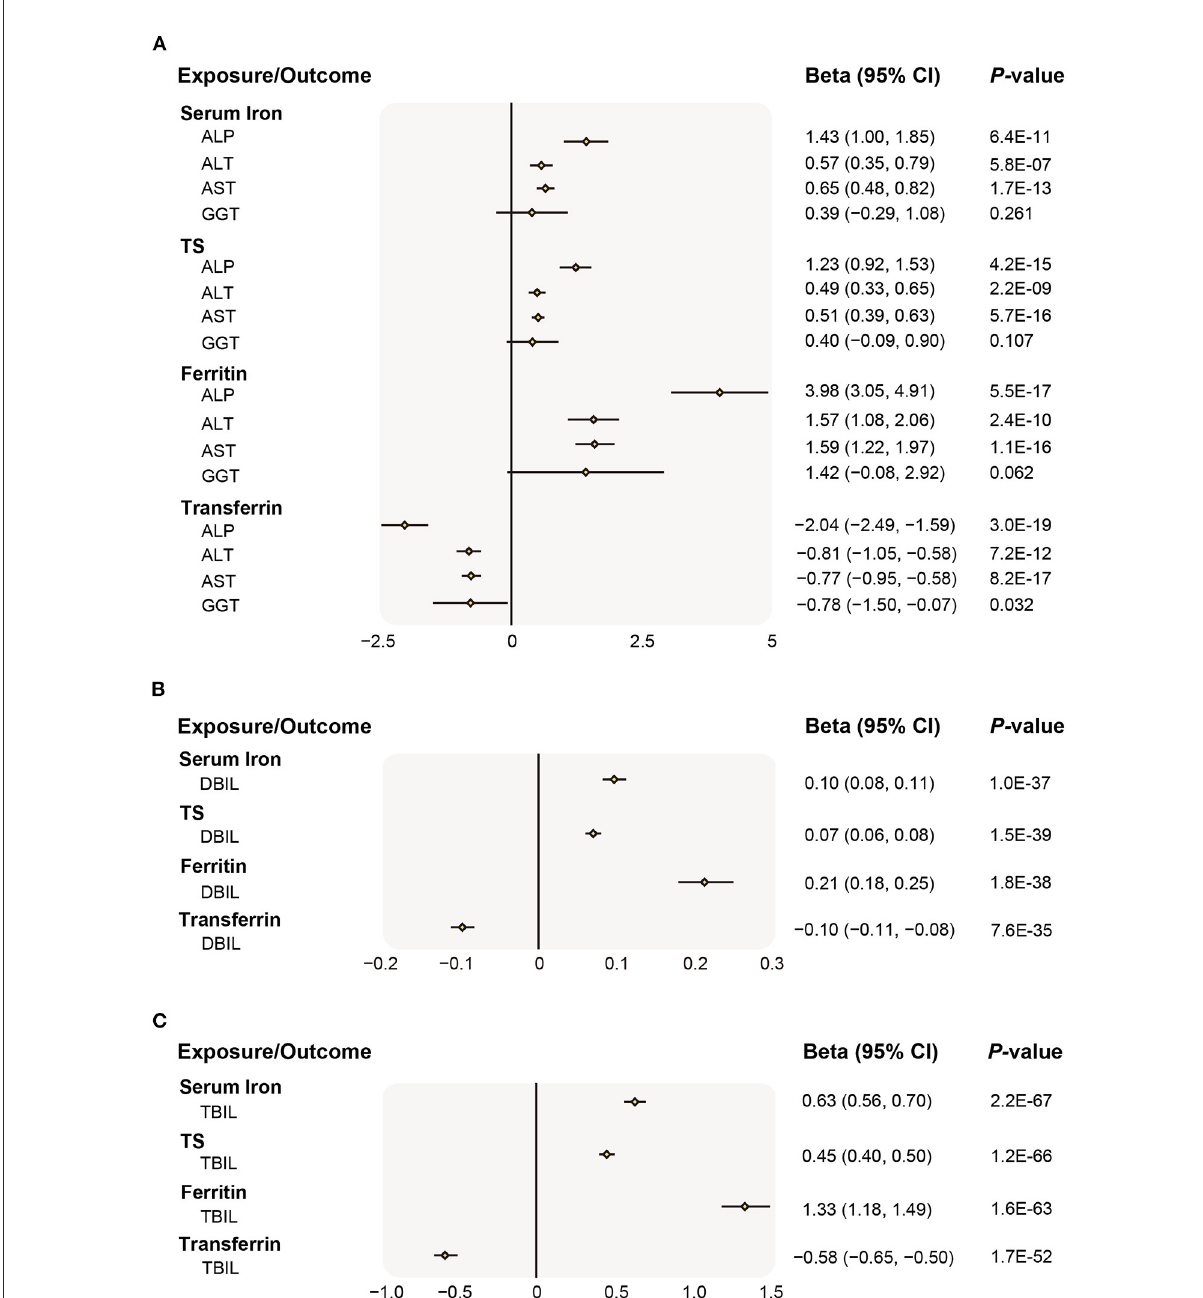
FIGURE2 Associations of genetically preidicted iron status and liver biomarker. (A) Causal effects of iron status on ALP, ALT, AST, GGT; (B) Causal effects of iron status on DBIL; (C) Causal effects of iron status on TBIL. The beta (95% CI) of standardized liver biomarkers (ALP, ALT, AST, GGT, DBIL, and TBIL) per SD increase of iron status biomarkers were estimated using fixed-effect inverse-variance weighted meta-analysis. Beta, the Mendelian Randomization effect of continuous variable outcome; 95% CI, 95% confidence interval; ALP, alkaline phosphatase; ALT, alanine aminotransferase; AST, aspartate aminotransferase; GGT, gamma glutamyltransferase; DBIL, direct bilirubin; and TBIL, total bilirubin; SD, standard